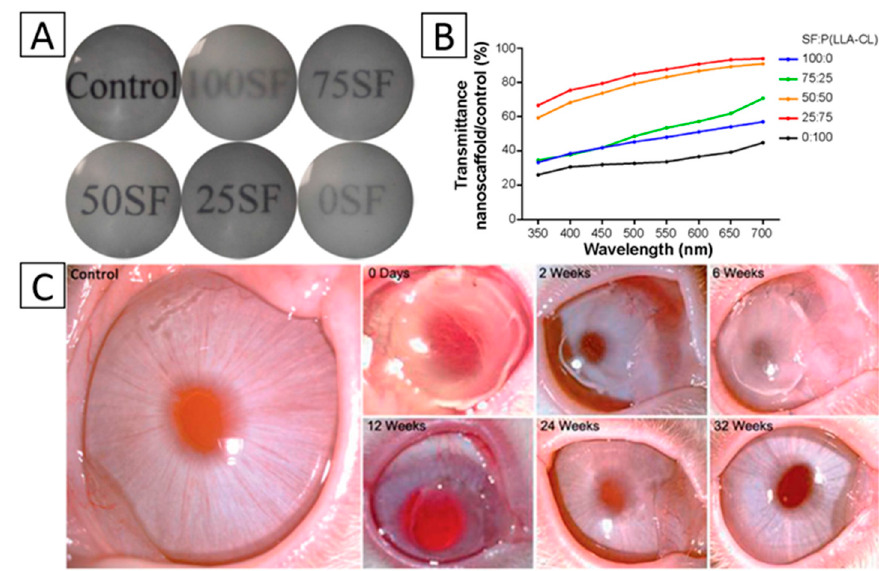
Figure 4. Transmission of light in nanofibrous membranes. ( A ) General transmission of light with different blend ratios; ( B ) Accurate transmission percentage compared with the control group of A. Panels ( A , B ), Reproduced from [56], with permission from © 2015 Chen et al; ( C ) Restorative process of the corneal transparency of NZWRs during a 32-week post-operative slit-lamp examination. Reproduced from [55], with permission from © 2015 The Royal Society of Chemistry.